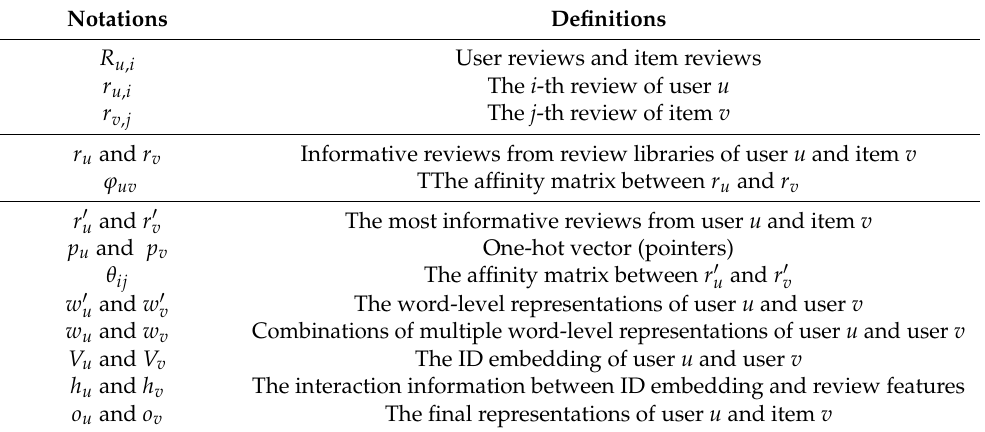
Table 1. Notations and